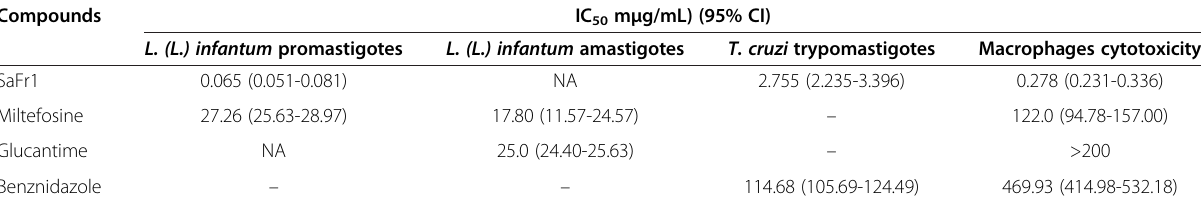
Table 1 Antiparasitic activity and cytotoxicity of SaFr1, the viability was determined by the colorimetric assay of MTT at 570 nm